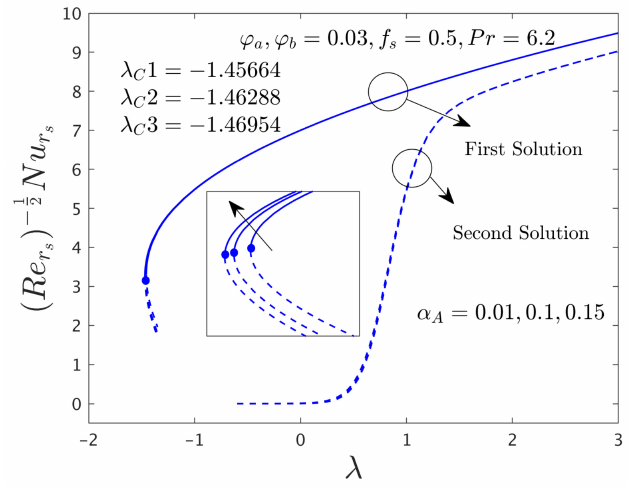
Nu r against λ for numerous choices of α A . s s